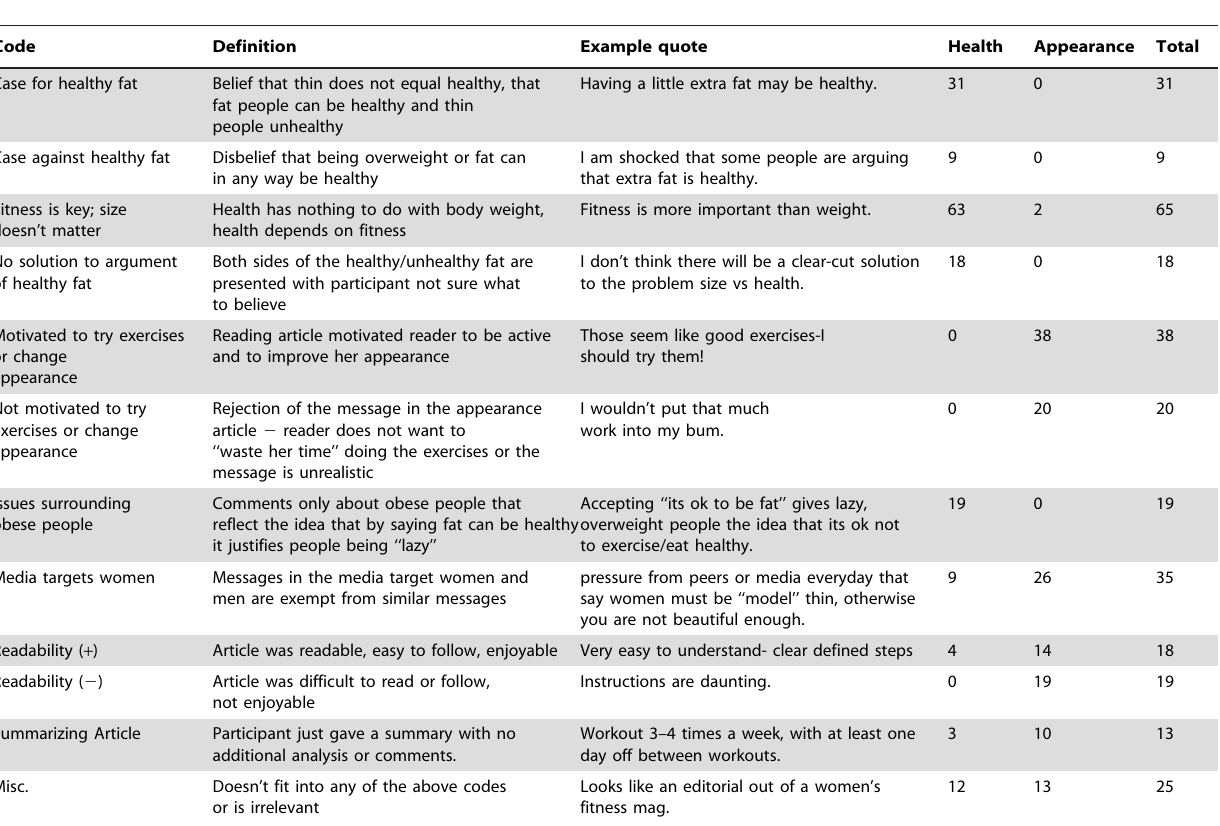
Table 3. Final thought listing codes reflecting the processing of the messages, their definitions, example quotes and number of comments by health and appearance